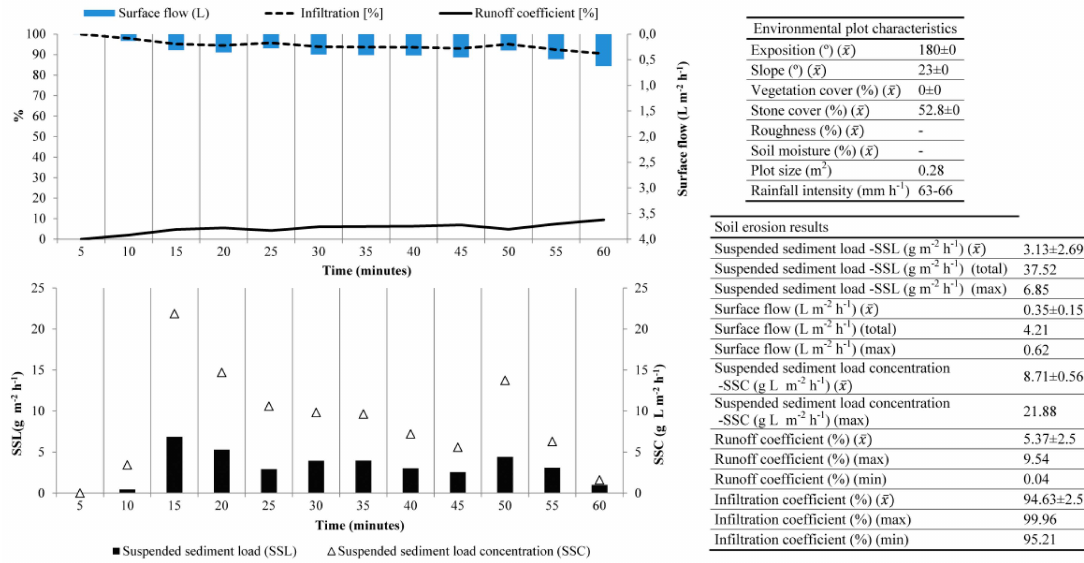
Figure 4. Rainfall simulations in Montes de Málaga (Andalucía, Spain).